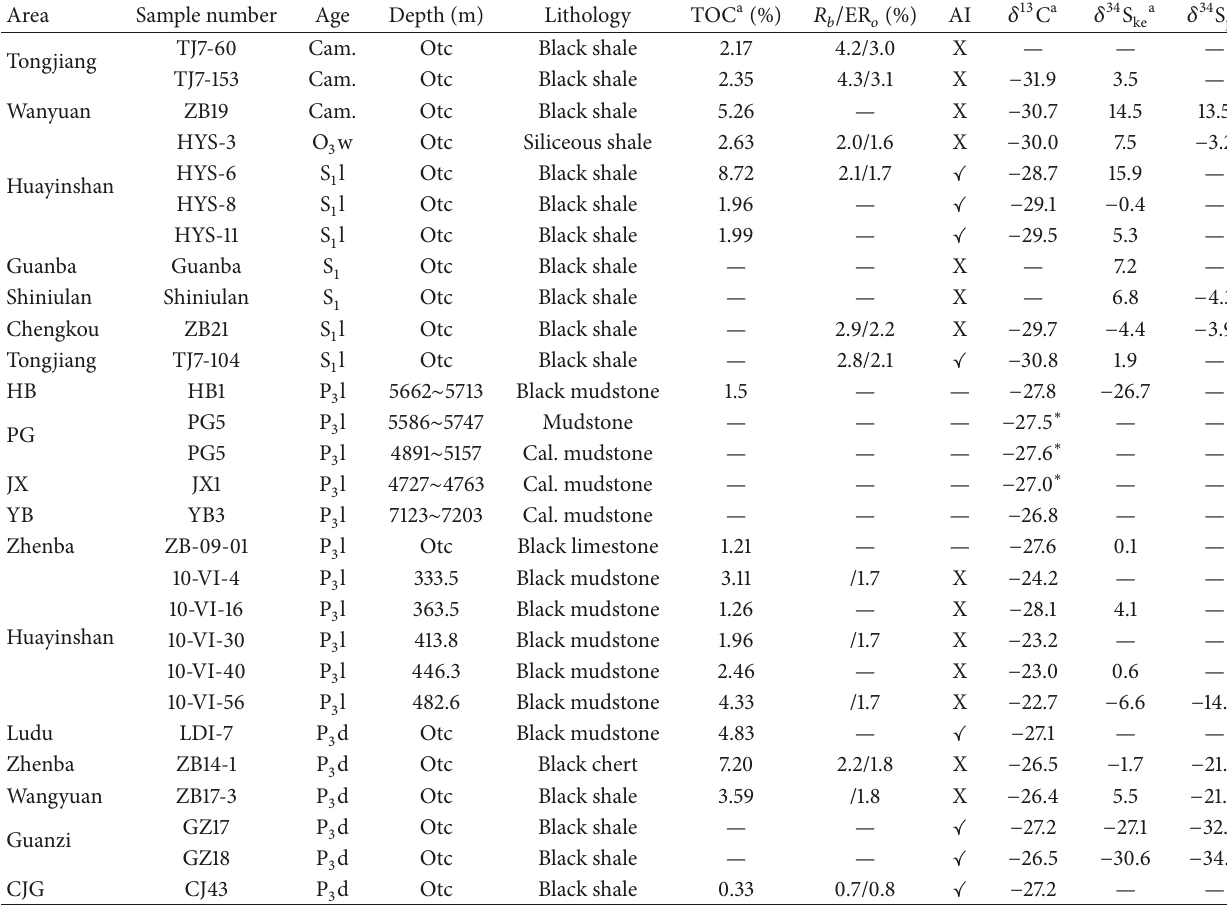
Table 1: Potential source rock TOC and aryl isoprenoids (AI), its kerogen vitrinite reflectance 𝑅 𝑜 , and S/C atomic ratio and 𝛿 13 C and 𝛿 34 S values.